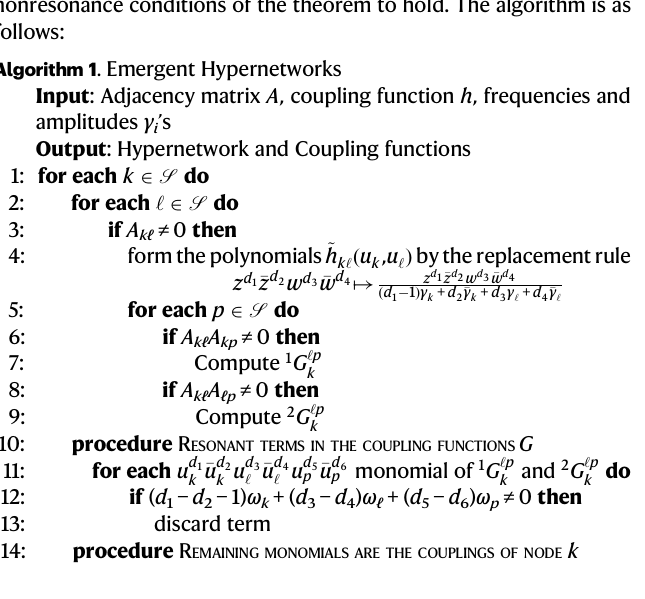
Algorithm 1 . Emergent